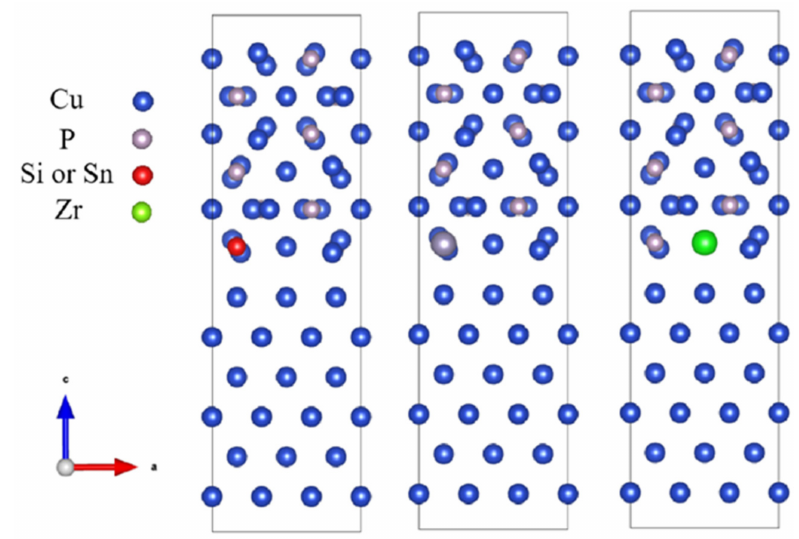
Figure 4. The doped CuP-X/Cu interface